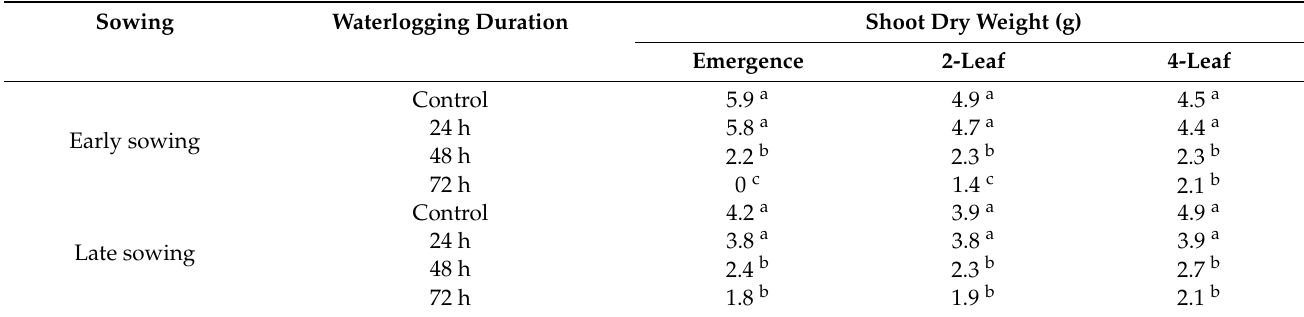
Table 2. Effect of waterlogging duration and stage of plant development on shoot dry weight (g) per square meter in Dacope in the Khulna district of Bangladesh.